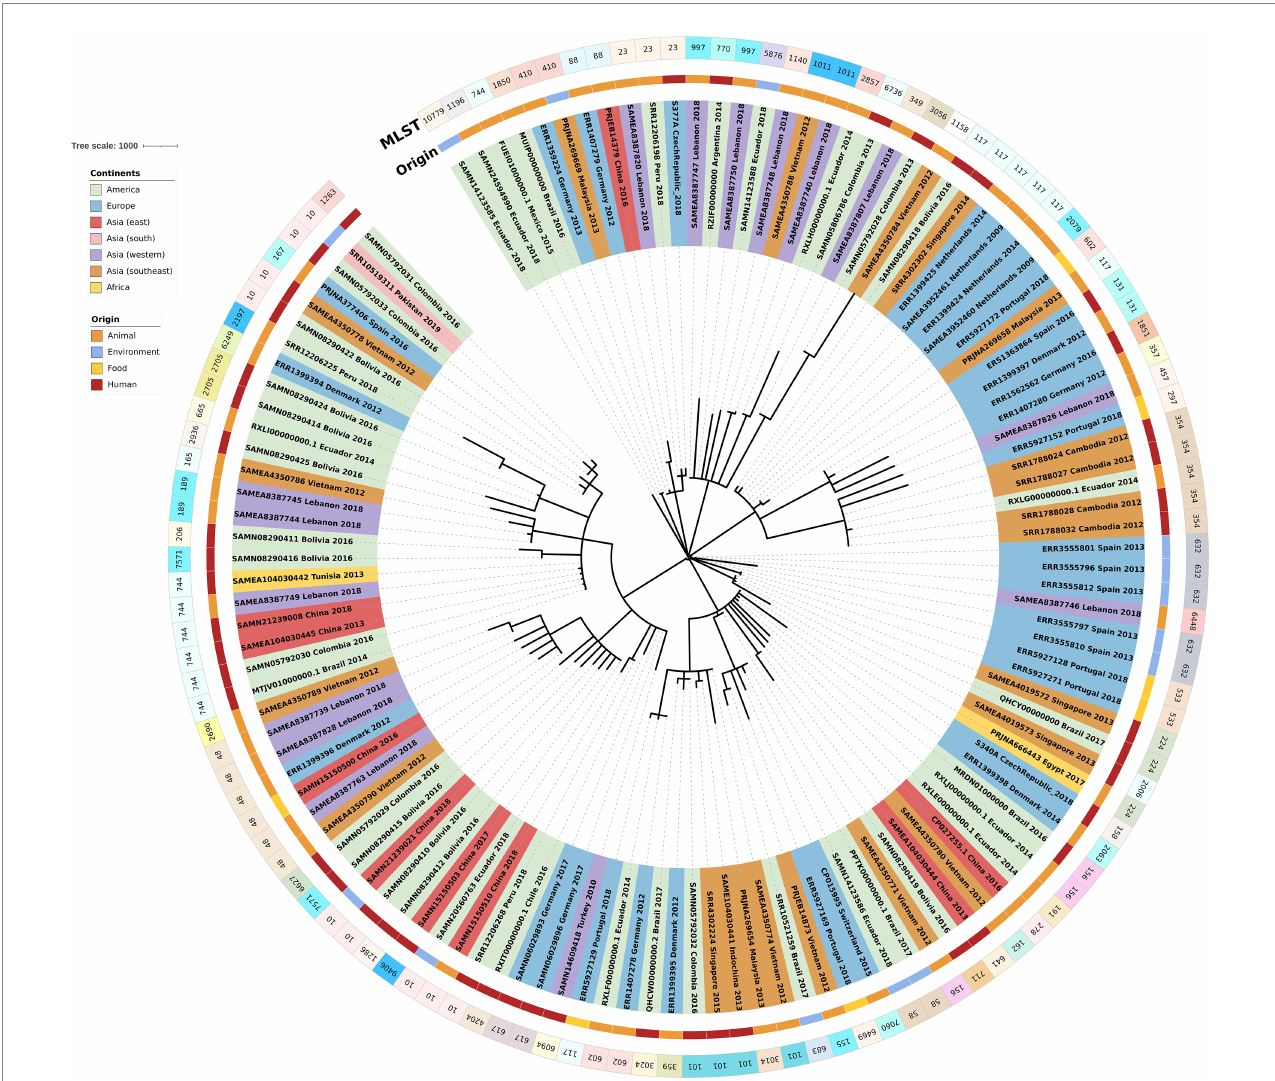
FIGURE 1 Phylogenetic tree of the core-genome multilocus sequence type allelic profiles of mcr-1 harboring Escherichia coli isolates evaluated in this study. Clusters are colored and labeled according to their continent of origin and the source of